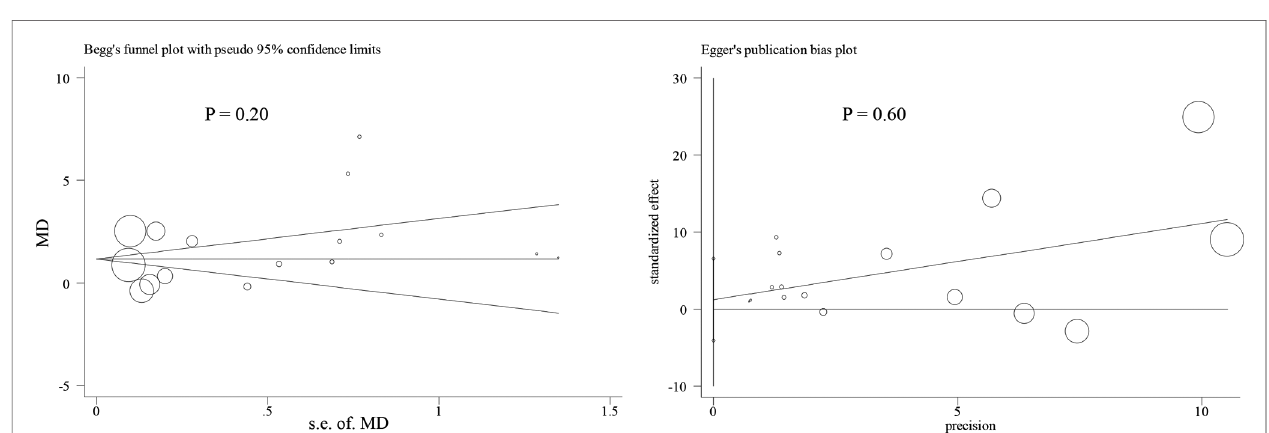
FIGURE 5 | Sensitivity analysis for the relationship of BMI with the onset of OSL.